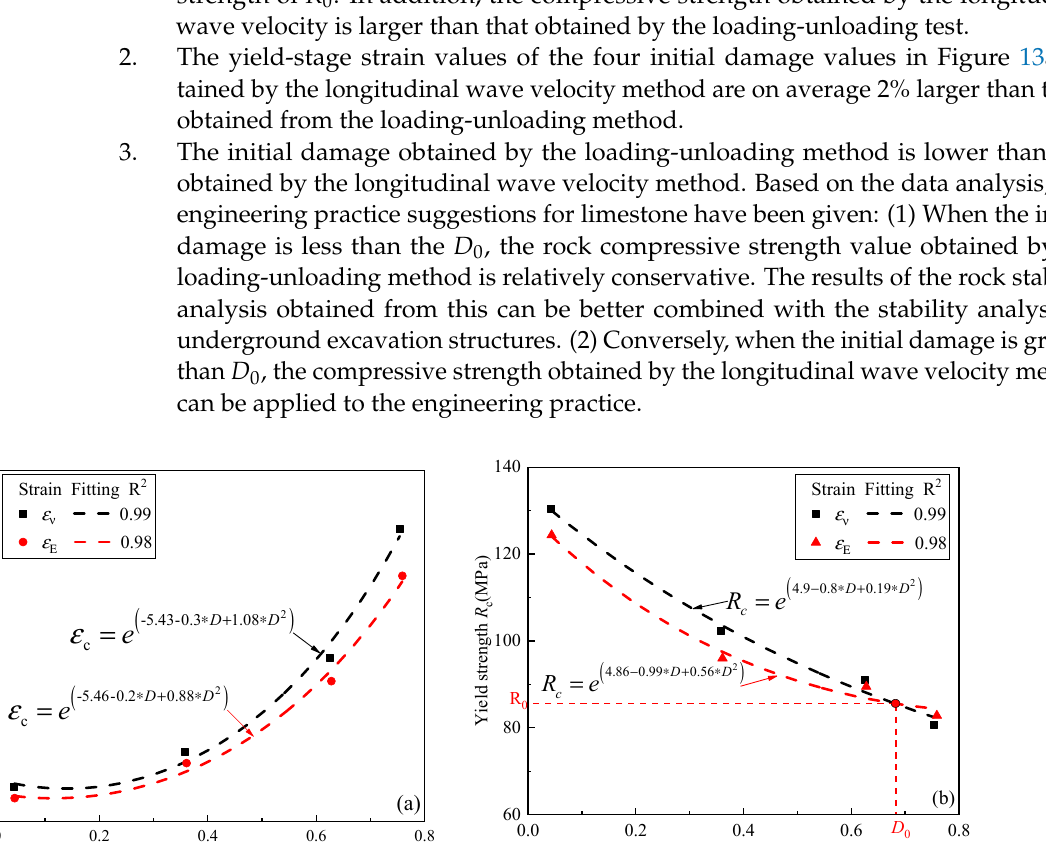
where R c is the compressive strength; ε c is the compressive strain of strength; ε is the loading strain rate; D is the initial damage; and a , b , and c are the quotieties. Table 9. Compressive strength and destructive strain of D E and D v. No The peak compressive strength remains stable when the initial damage is minor. When the initial damage value reaches a particular value, the corresponding com- pressive strength begins to decrease dramatically, and the initial damage value reaches an inflection point, which is the initial damage threshold value, as shown by a red dotted line. The initial damage threshold values of the two loading strain rates ( 𝜀 (cid:3364) = 100 s − 1 , 2 × 10 − 4 s − 1 ) are 𝐷 (cid:3047)(cid:3035)(cid:3045)(cid:2869) and 𝐷 (cid:3047)(cid:3035)(cid:3045)(cid:2870) , and the values of 𝐷 𝑡ℎ𝑟1 and 𝐷 (cid:3047)(cid:3035)(cid:3045)(cid:2870) are 0.2 and 0.18, respectively.